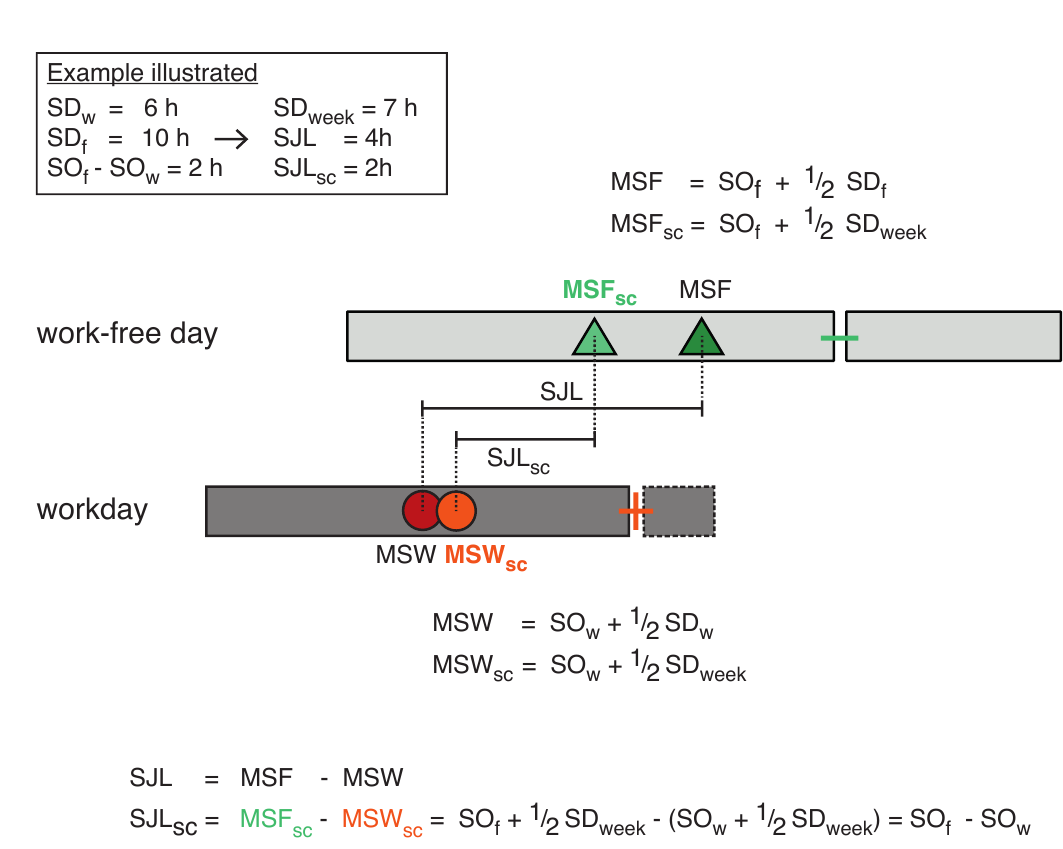
Figure 6. Social jetlag computation. This schematic illustrates the calculations of social jetlag (SJL) [5] and that for social jetlag sleep-corrected (SJL sc ) as recently suggested by Jankowski [98]. Bars illustrate sleep episodes, as well as their timing and duration, on work- and work-free days, and dots / triangles are the respective midsleep times either including or excluding the dashed parts of the sleep episode. SJL is based on uncorrected, actual midsleep times, thus representing the change of mid-darkness between workdays and free days. SJL sc uses midsleep times that were corrected for a potential oversleep or undersleep in an attempt to remove homeostatic confounders from the sleep schedule. The schematic is drawn to scale and is based on the scenario given in the box assuming a late chronotype with early work schedules in a week with five workdays and two work-free days. Abbreviations: SD w / f / week